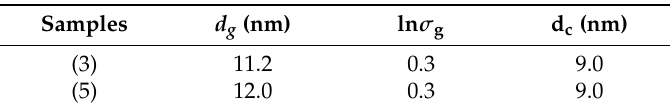
Table 1. Median size ( d g ), standard deviation (ln σ g ) based on the TEM results, and grain size (d c ) based on the XRD results for samples (3) and (5).